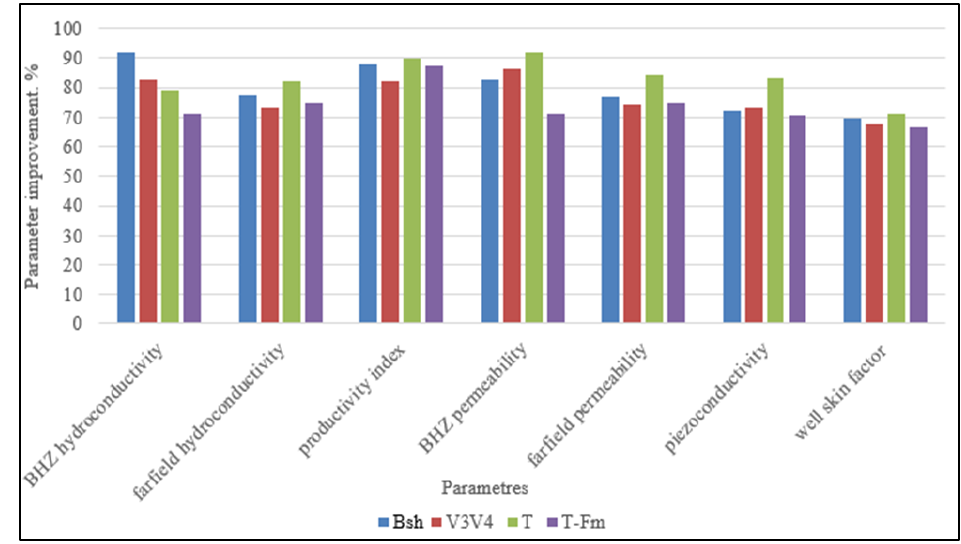
Figure 3. Success of the hydrodynamic parameter change after RJD, by formations.